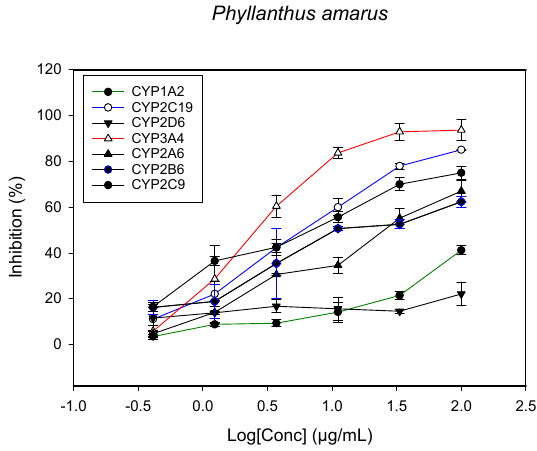
Figure 6. The inhibitory effect of graded concentrations of the extracts of P. amarus on the metabolic activity of cytochrome P450 enzymes.